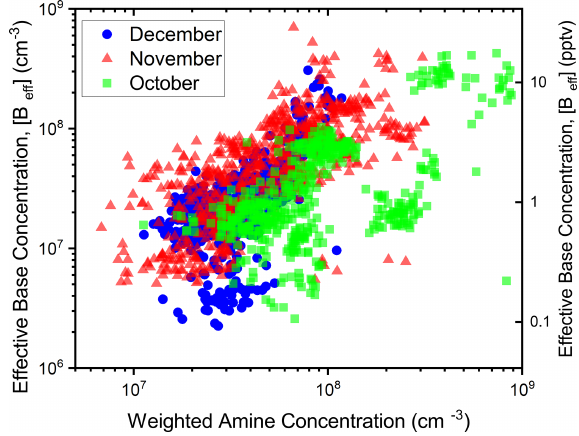
Figure 4. Comparison of effective base concentration from the NPM ([ B eff ]) with the weighted amine concentration measured in Beijing, China in 2018. October measurements are green squares, November red triangles, and December blue